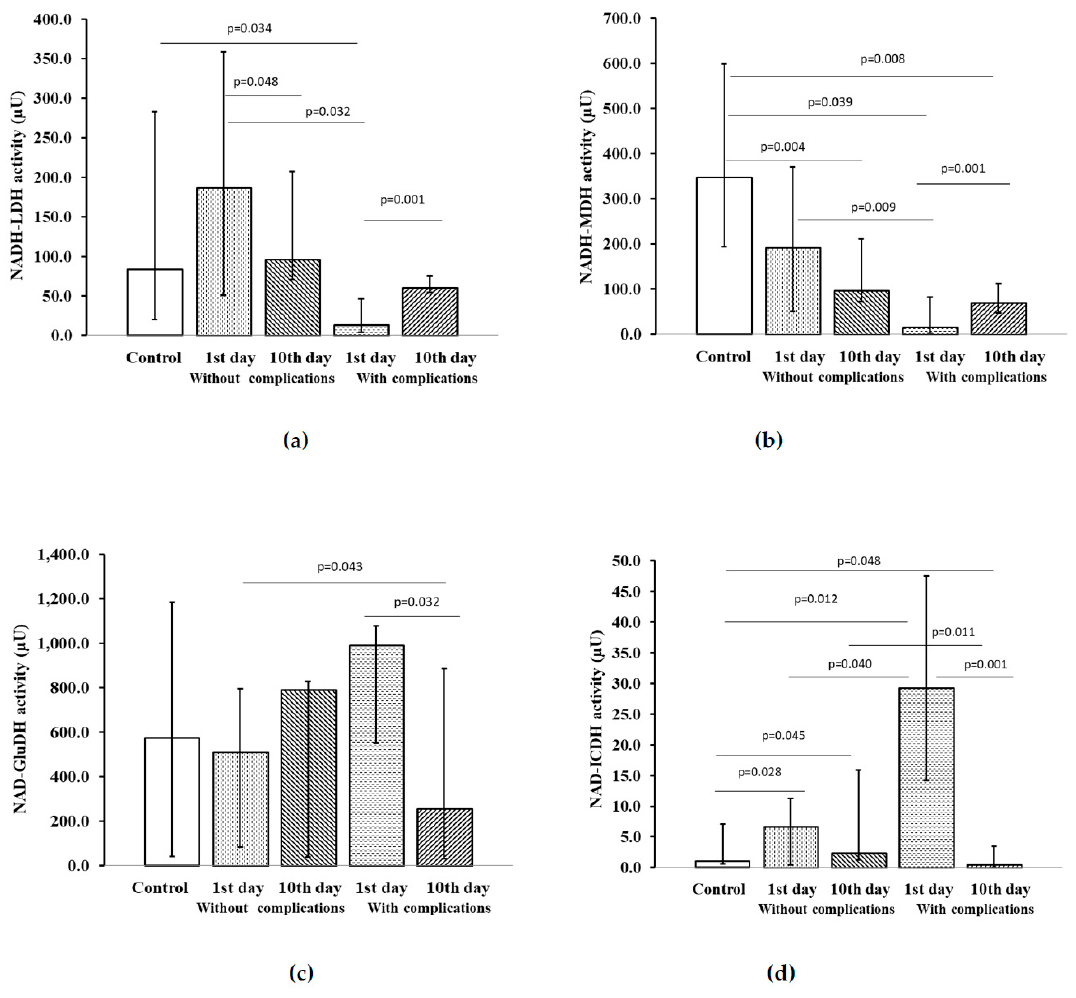
Figure 2. Activity of NAD-dependent platelet dehydrogenases in patients with ACS without ADD, depending on the development of cardiovascular complications: ( a ) NADH–LDH activity; ( b ) NADH–MDH activity; ( c ) NAD–GluDH activity; ( d ) NAD–ICDH activity. Notes: Values expressed as median and interquartile range in the form of 25 and 75 percentiles, p < 0.05 was considered statistically significant. Wilcoxon matched-pairs test for patients without complications on the 1st vs. 10th day of the examination and for patients with complications on the 1st vs. 10th day of the examination. Mann–Whitney U test for patients vs. control subjects and for patients with complications vs. patients without complications. Notes: µ